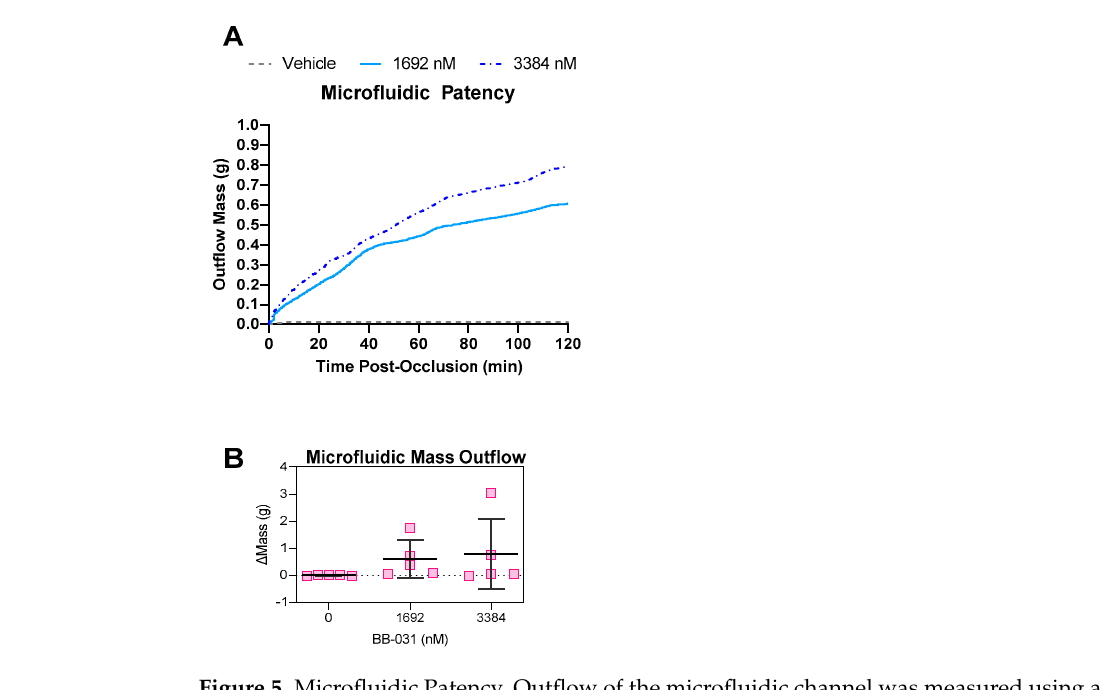
Figure 5. Microfluidic Patency. Outflow of the microfluidic channel was measured using a scale to determine the patency of the channel and assess recanalization. No change in mass represents no flow (not patent/occluded). ( A ) Mean traces are shown for vehicle, treatment with 1692 nM BB-031, and treatment with 3384 nM BB-031, N = 5 each. The raw mass output was smoothed using a LOESS function to account for erroneous jumps due to movement or instability external to the experiment. ( B ) The change in mass was calculated by subtracting the last mass value from the first mass value Individual data points are shown in ( B ). Error bars represent mean ± standard deviation